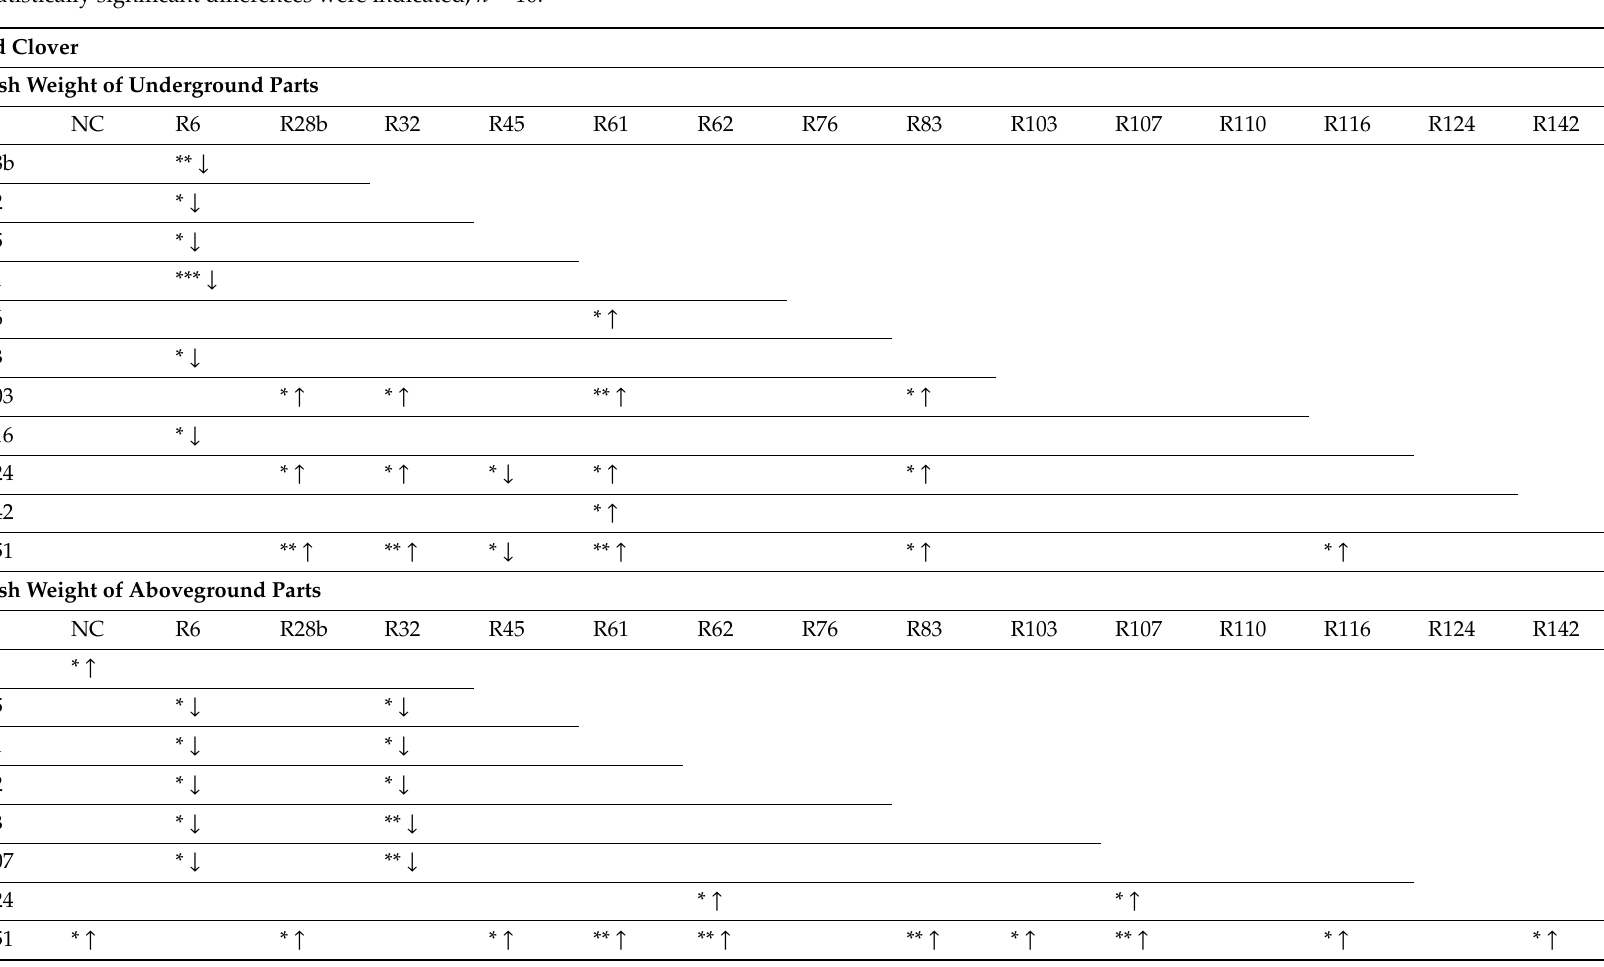
Table 3. Statistical analysis of results of comparison of underground parts weight, aboveground parts weight, and nodules number of red clover plant